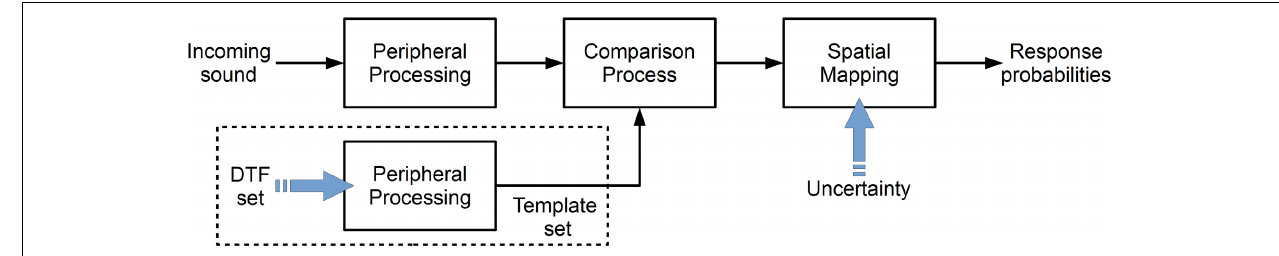
FIGURE 1 | Structure of the sound localization model from Baumgartner et al. (2013). The incoming target sound is peripherally processed and the result is compared to an internal template set. The comparison result is mapped yielding the probability for